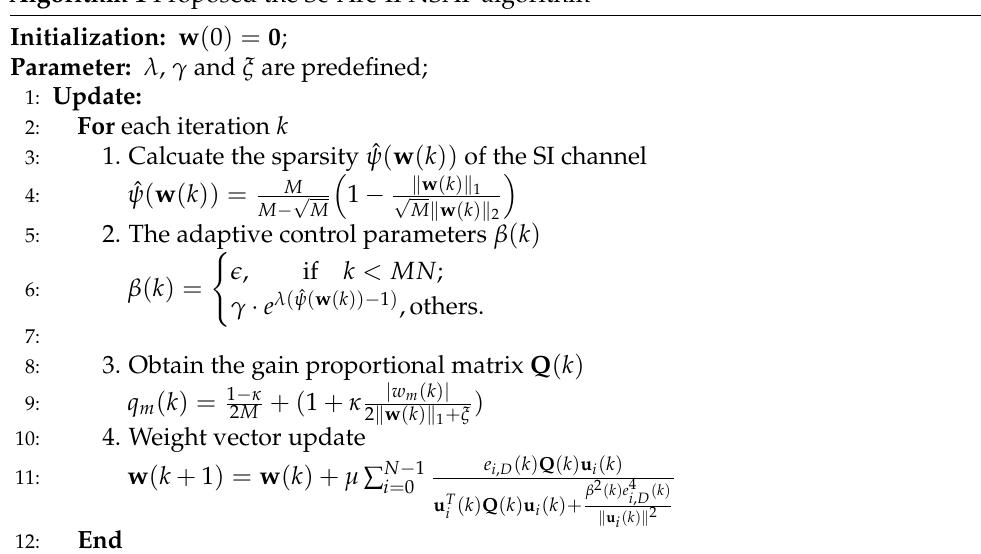
Figure 3. The adaptive control parameter β ( k ) varies with sparsity value ψ ( w 0 ) when λ = 2,4,6,8. Algorithm 1 Proposed the Sc-Arc-IPNSAF